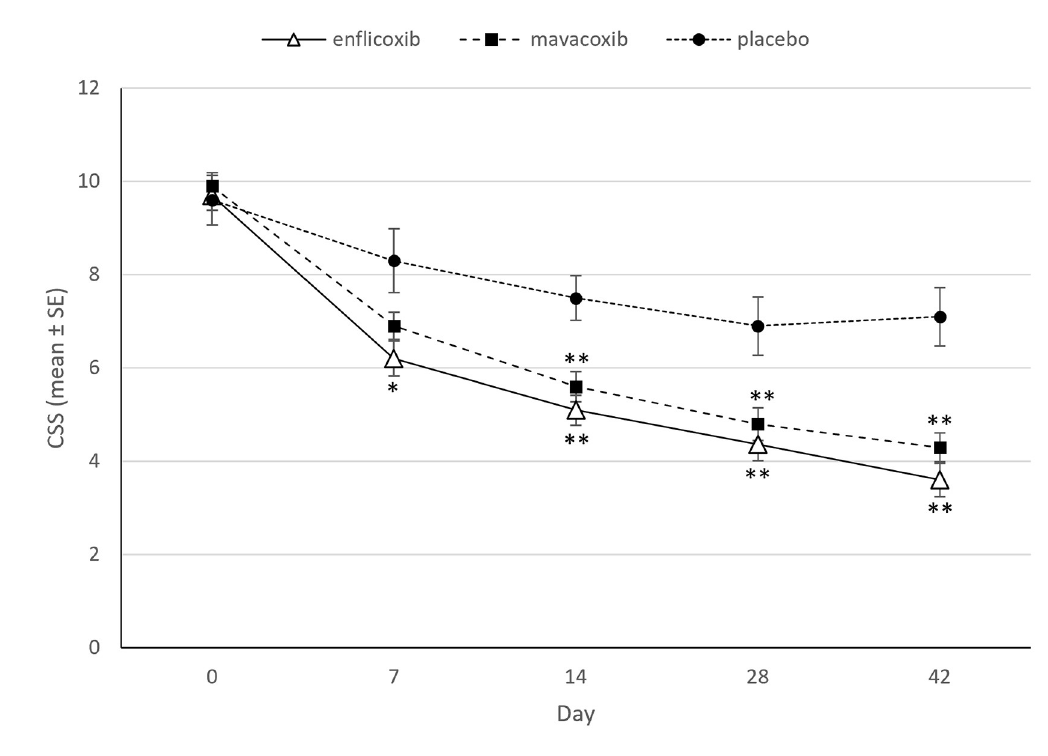
Fig 2. Average CSS (mean ± Standard Error) for each time point and treatment. Asterisks indicate superiority vs placebo ( � p < 0.05 �� p < 0.01).